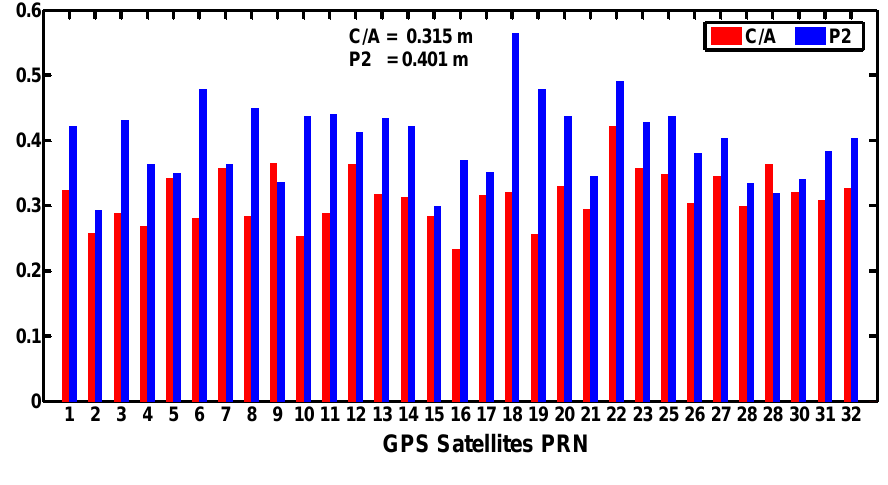
Figure 6. Standard deviations of MPCs of C/A and P2 codes of GPS satellites at CHDU station on September 24,